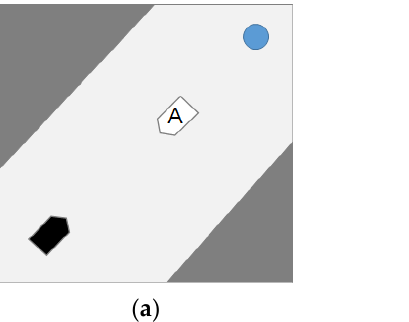
Figure 4. ( a ) Other ships approaching in front added to the autonomous ship (black) learned obstacle avoidance and basic path finding through the local curriculum. ( b ) Comparison of the values from the first learning scenario and those from 2000 scenario learnings to obtain the 𝑉 (cid:3050) (𝑠 (cid:3047) ) of the critic. To extract the critic value, (ε) is fixed, and the critic is activated before and after the learning. The additional training before (blue) and after (red) is compared. After additional training, the critic is higher with low actions.